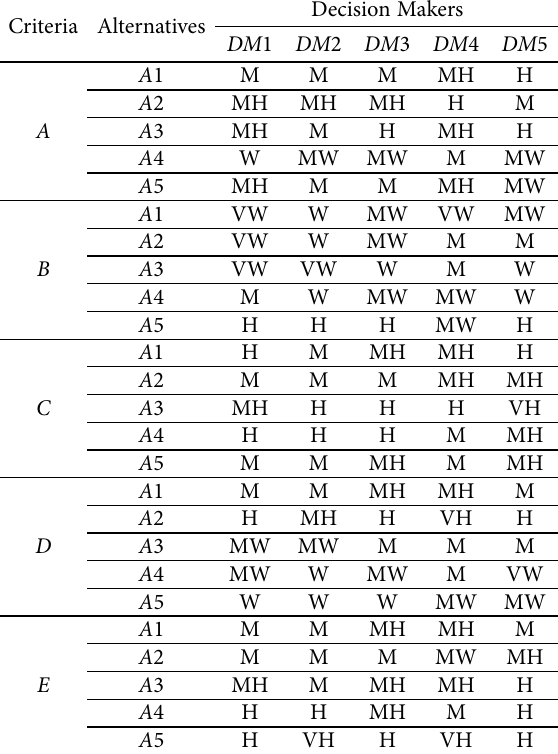
Table 5. The opinion of decision makers for each alternative on the basis of criterion